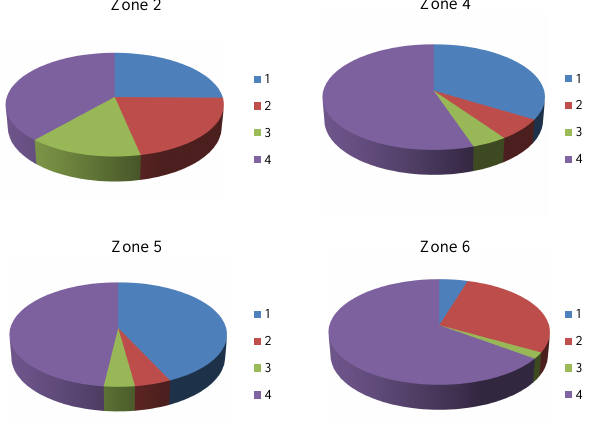
and conclude that the samples do not have the same distribu-